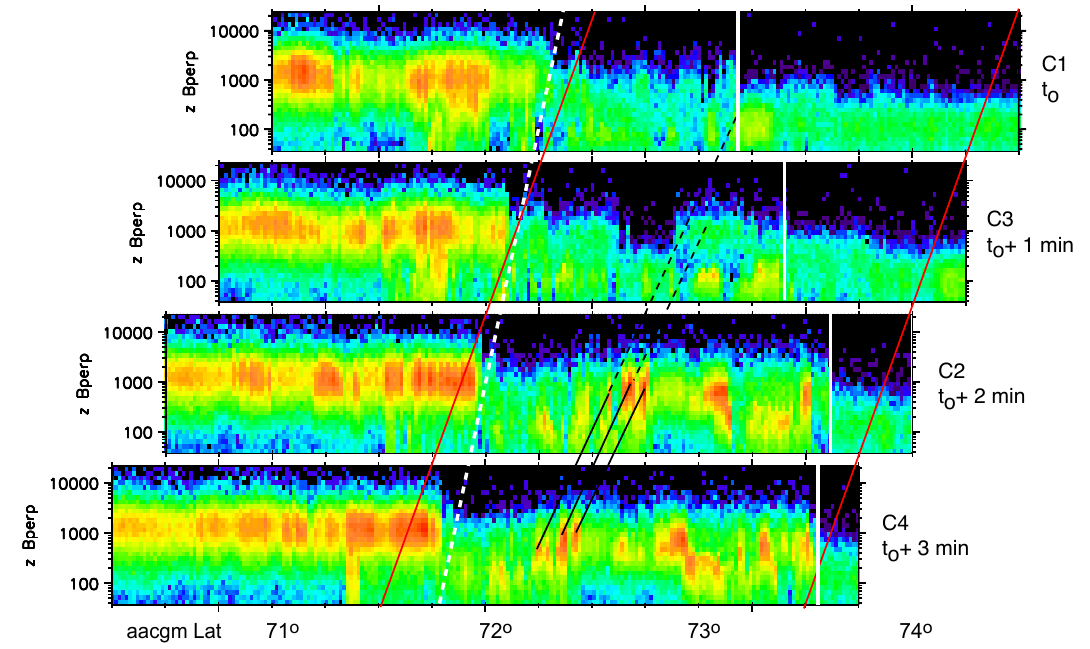
Fig. 15. Perpendicular electron fluxes from C1 (top panel), C3, C2 and C4 (bottom panel) presented as a function of geomagnetic latitude. The time interval covered by each of the satellites is 22:08–22:22UT. The white dashed line shows the drift motion of the “original PCB” and the solid white lines the approximate locations of the final PCB. For details, see the